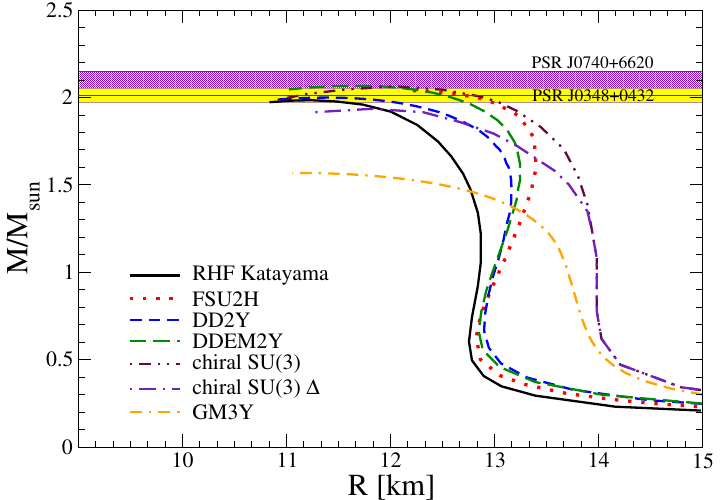
Figure 1. Mass-radius relations for several EOSs models discussed in the text. The observed pulsars PSR J0348+0432 [103] and PSR J0740+6620 [104], which are represented by yellow and purple bands, respectively, indicate the uncertainty on the measurement. See text for